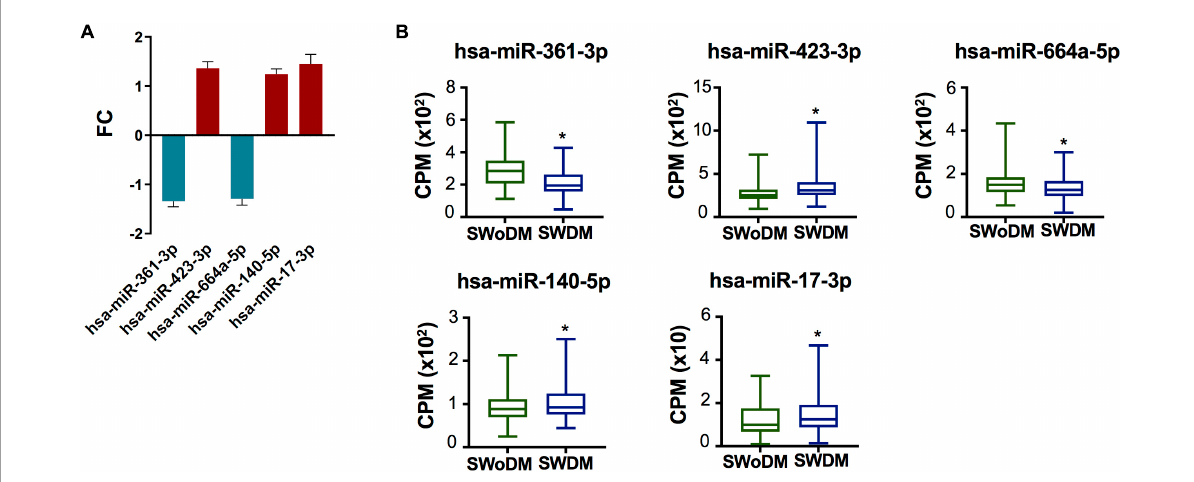
FIGURE3 Validated miRNAs in SWDM patients compared to SWoDM patients. (A) Column plot shows the fold change (FC) and standard error of the mean (SEM) of FDR-significant validated, differentially regulated miRNAs ( n = 5) in SWDM versus SWoDM patients: downregulated in teal and upregulated in crimson color. (B) Box and whiskers plots show the difference in counts per million (CPM) of the five validated miRNAs in SWDM and SWoDM patients. Mean with minimum and maximum values, upper and lower quartiles, and statistical significance ( P < 0.05) marked by an asterisk (*) are shown for each